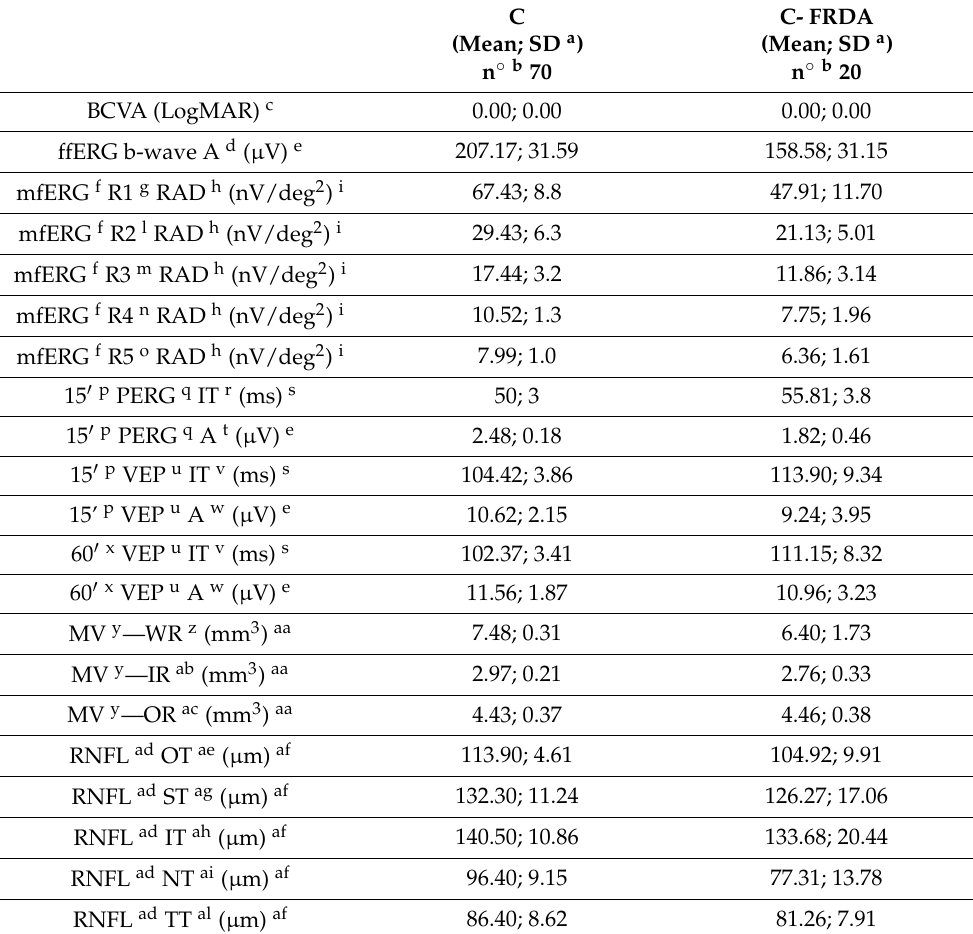
Table 1. Descriptive statistics: mean and standard deviation values of the functional and mor- phological retina and optic nerve parameters in carriers of Friedreich’s ataxia (C-FRDA) eyes and Control eyes